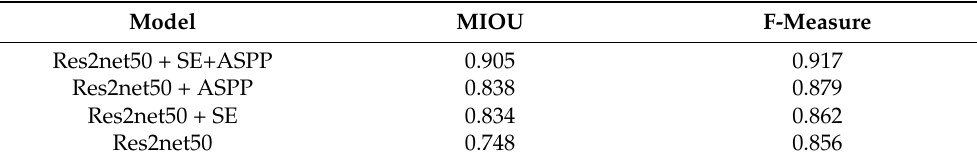
Table 1. Ablation test